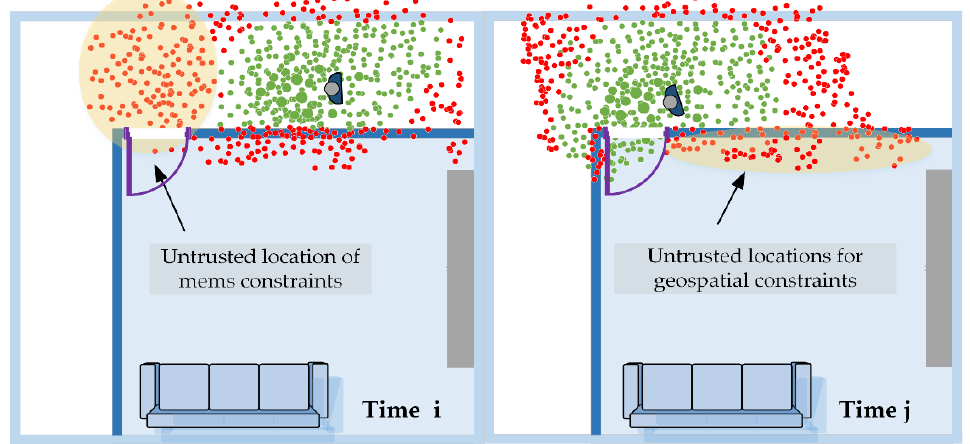
Figure 13. Trusted evaluation mechanism based on heterogeneous information.